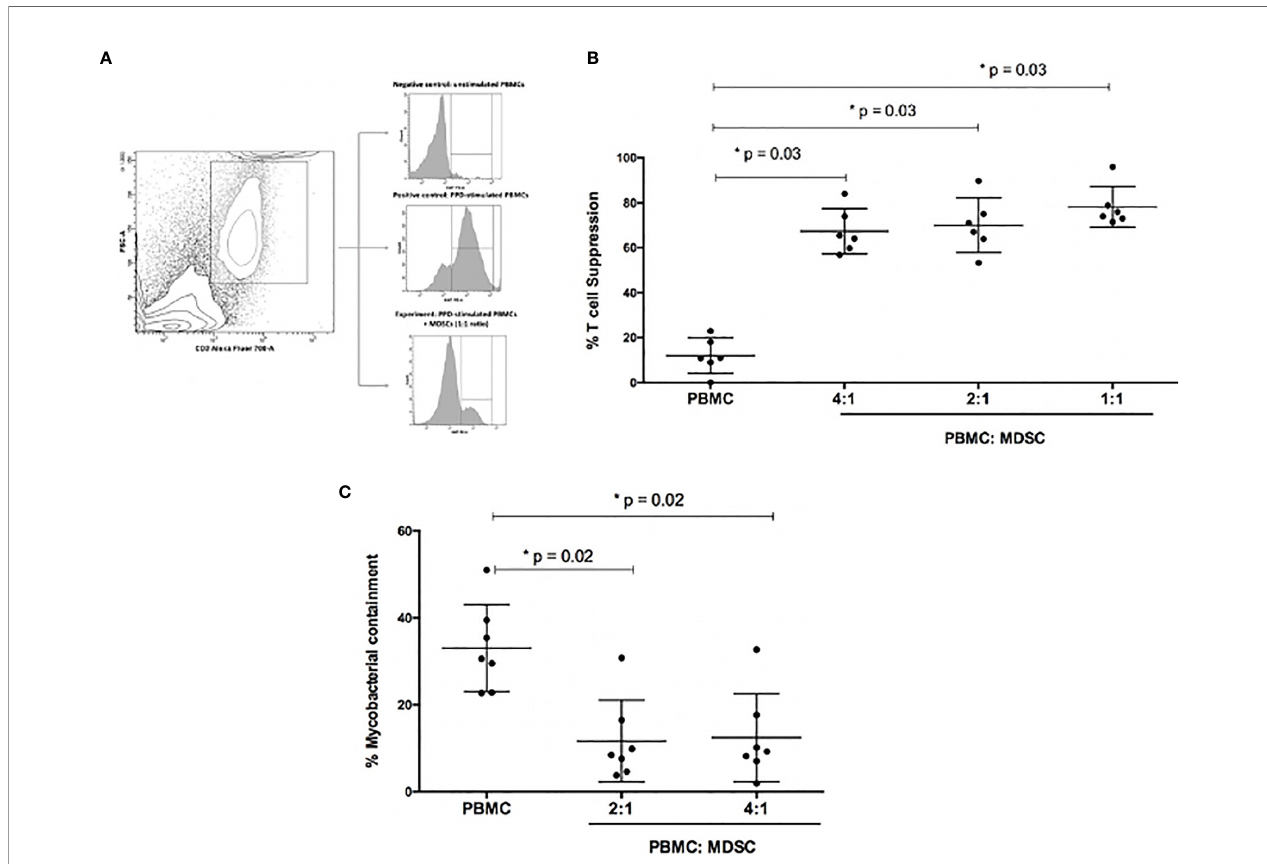
FIGURE 2 | Functional capabilities of myeloid derived suppressor cells (MDSC) was tested. (A) Illustrates the fl ow cytometry gating strategy. (B) Outlines suppression of PPD-driven T-cell proliferation by MDSCs at different ratios. Effector T-cells were co-cultured with MDSCs at a ratio of 4:1, 2:1 and 1:1, respectively. The percentage proliferation was measured using Ki67 fl ow cytometry staining. (C) Mycobacterial containment assays using peripheral blood cells from active TB patients to determine the effect of MDSCs from TB patients on mycobacterial survival. Brie fl y, monocyte-derived macrophages (MDMs) were infected with H37Rv and then co-cultured with PPD pre-primed effector T-cells with or without MDSCs for 24 hours. Theimpact of MDSCs on mycobacterial containment was assessed by plating surviving intracellular bacteria, and the magnitude of mycobacterial containment is expressed as % of the reference control (MDM only) for each experimental condition. *p-value of <0.05 were considered signi fi cant (Wilcoxon matched pairs